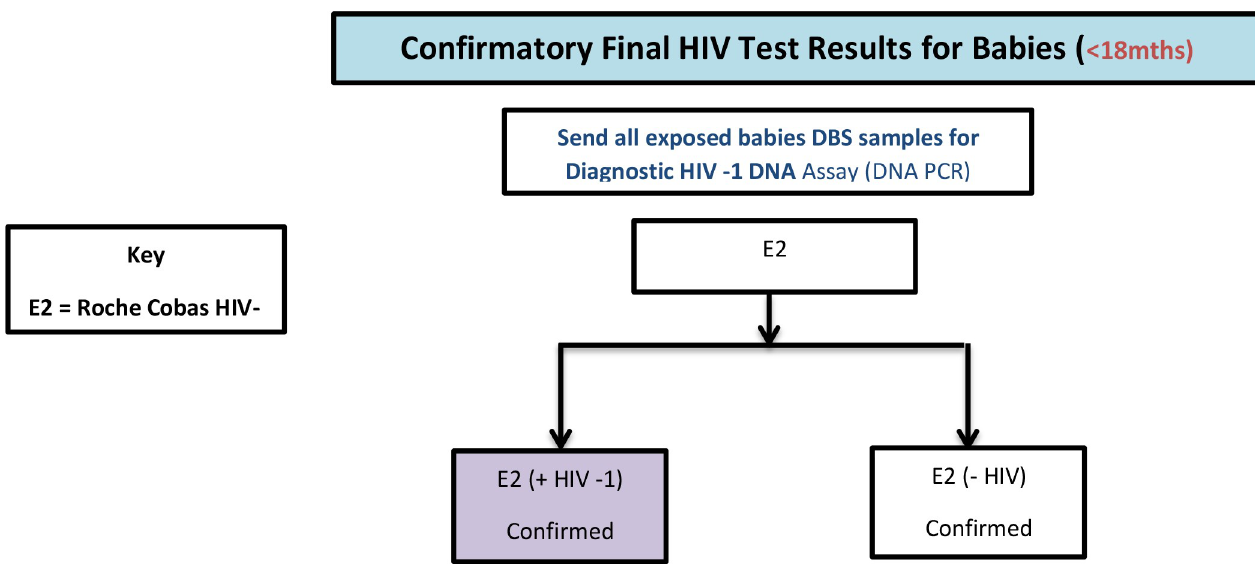
Fig 3. Confirmatory HIV testing algorithm for babies ( < 18months), AKAIS 2017.